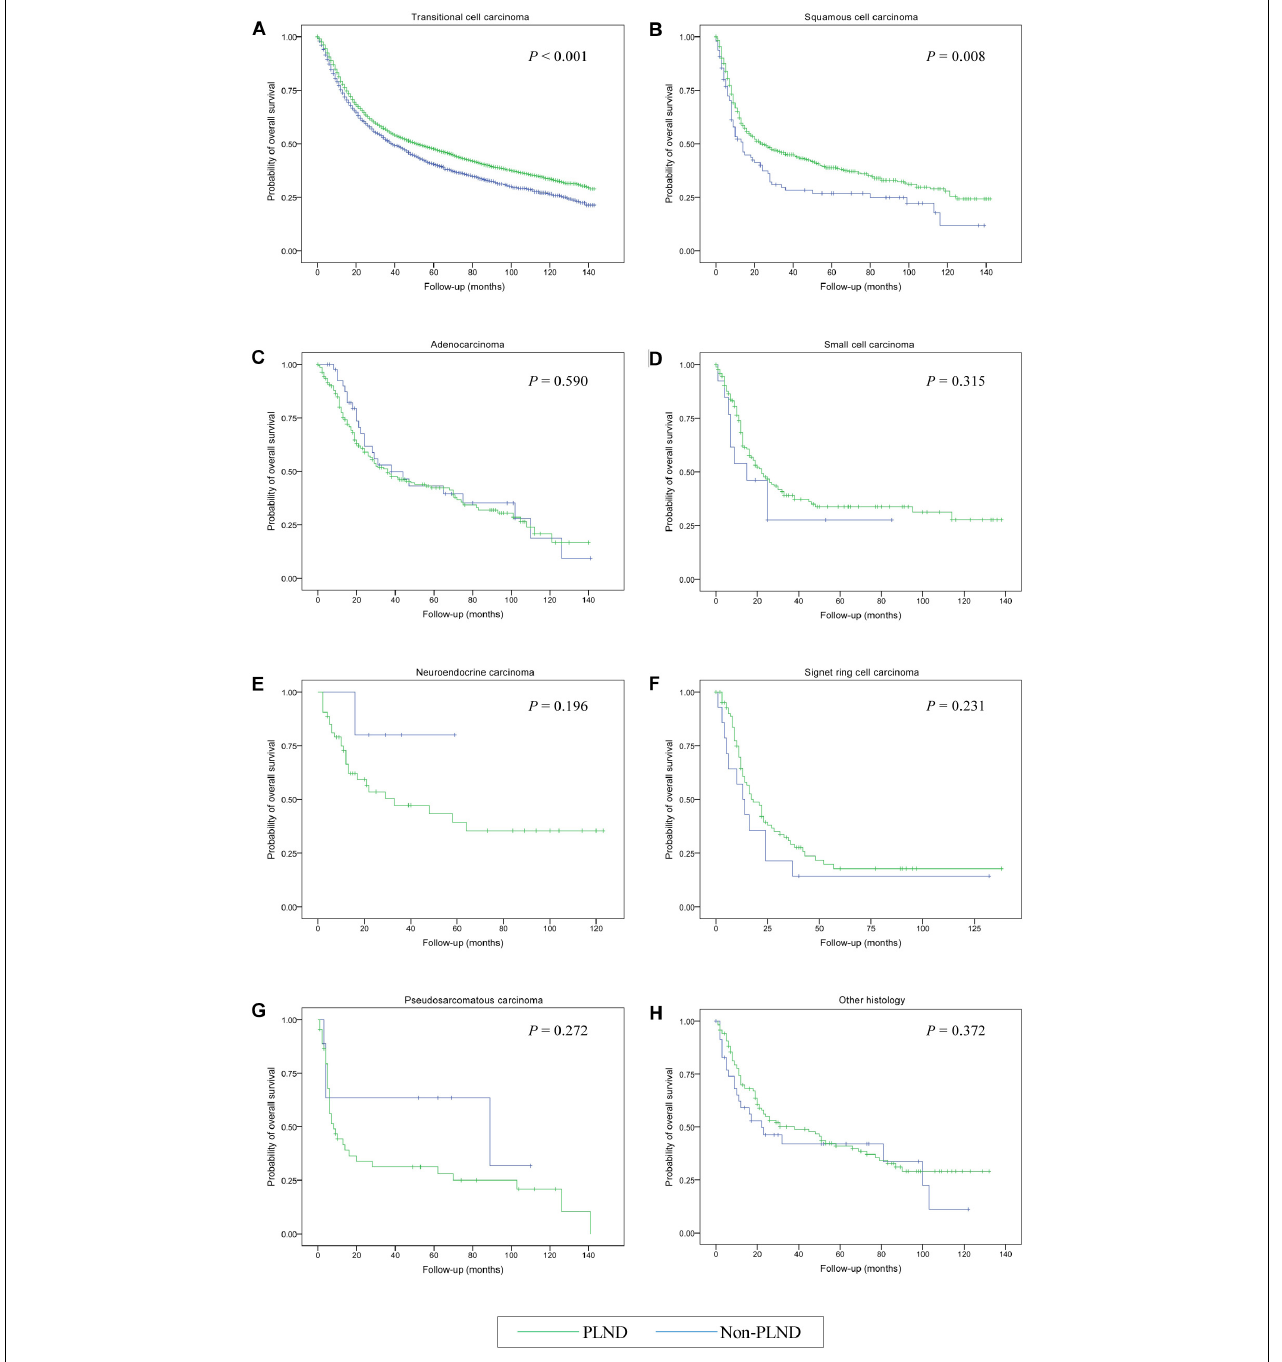
FIGURE 2 | Kaplan-Meier analysis of overall survival in patients who received cystectomy and pelvic lymph node dissection (PLND) versus cystectomy only for the treatment of bladder cancer with different histologic types. (A) Transitional cell carcinoma; (B) Squamous cell carcinoma; (C) Adenocarcinoma; (D) Small cell carcinoma; (E) Neuroendocrine carcinoma; (F) Signet ring cell carcinoma; (G) Pseudosarcomatous carcinoma; (H) Other